Question: Write a caption explaining this figure to a reader.
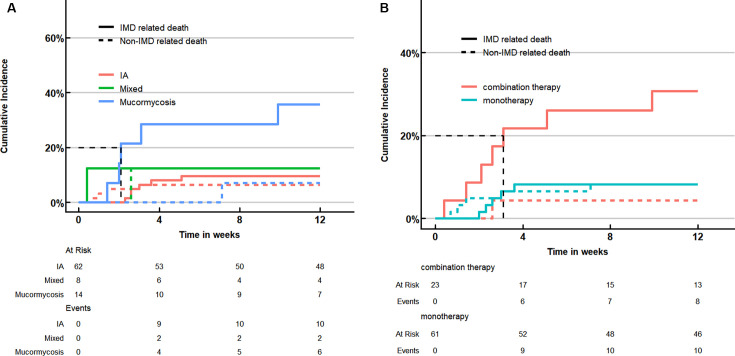
Answer: Cumulative incidence of IMD-associated mortality at week 12. ( A ) According to infection type (IA, mucormycosis, and mixed infection). ( B ) According to treatment strategy (monotherapy vs. combination therapy). Solid lines represent the cumulative incidence of IMD-associated mortality, and dashed lines represent non-IMD mortality as competing events. The risk tables display the number of patients at risk at weeks 0, 4, 8, and 12. Gray’s test P -values: ( A ) P = 0.04 for overall comparison among the three infection types. ( B ) P = 0.01 for monotherapy vs. combination therapy. IA, invasive aspergillosis; IMD, invasive mold disease.